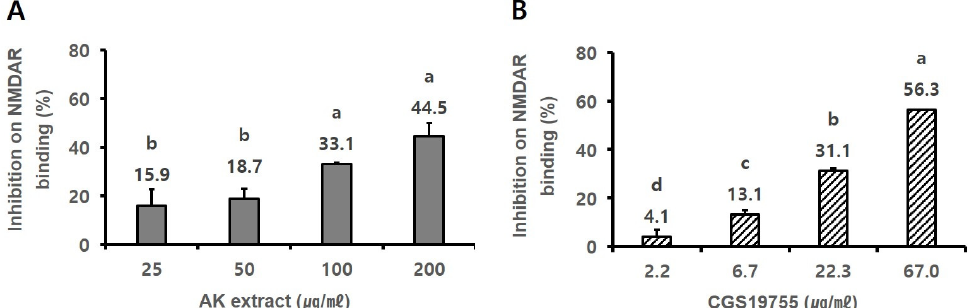
Figure 4. Inhibitory activities of control specific binding of ( A ) AK extract and ( B ) the reference compound (CGS19755) on NMDA receptors. The rat cerebral cortex membrane homogenate (1 mg protein) was incubated with 5 nM [3H] CGP39653 and AK extract in a buffer containing 5 mM Tris- HCl (pH 7.7) and 10 mM EDTA-Tris for 60 min at 4 ℃ . Nonspecific binding was determined in the presence of 100 µM L-glutamate. After incubation, the reactant was filtered through glass fibre filters in a vacuum and rinsed with an ice-cold buffer. The filters were dried and measured for radioactivity in a scintillation counter using a scintillation cocktail. Statistical analysis ( n = 2) was performed using SAS software. The values indicated with different letters were found to differ significantly at p < 0.05 by Duncan’s multiple range